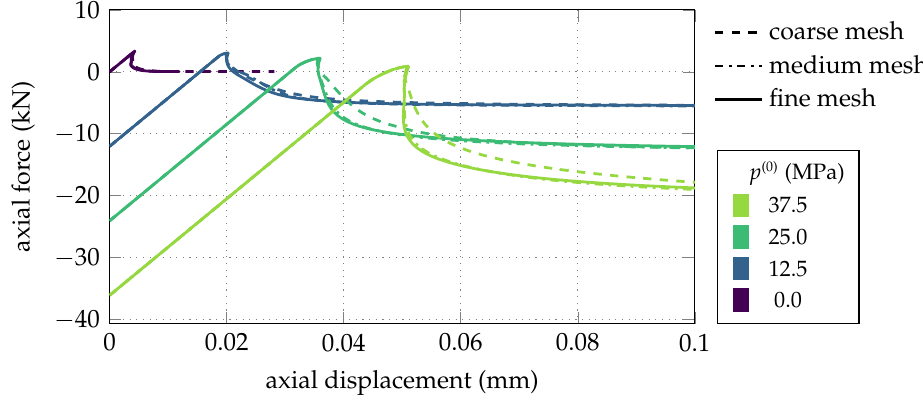
Figure 12. Computed load–displacement curves for triaxial extension tests for different levels of confining pressure p (0) .